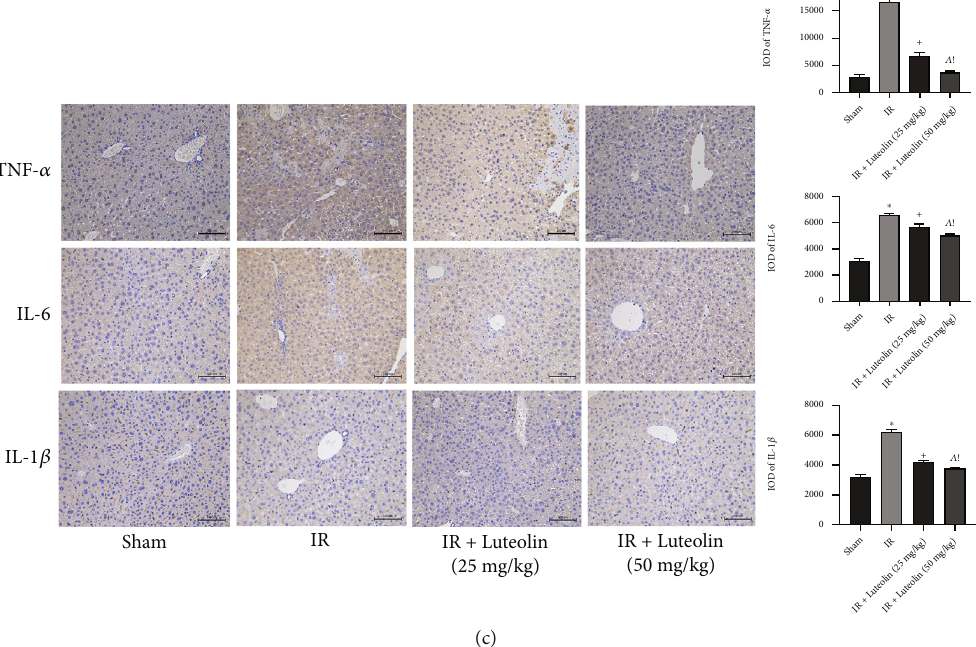
Figure 3: Luteolin reduced the expression of in fl ammatory cytokines. (a) Relative IL-6, IL-1 β , and TNF- α mRNA levels were determined by qRT-PCR. (b) Western blot results of TNF- α , IL-6, and IL-1 β protein levels. (c) Immunohistochemical staining (200x) showed expression of TNF- α , IL-6, and IL-1 β proteins in liver tissues 6 hours after reperfusion. Final evaluations were made by Image-Pro Plus 6.0 software to calculate the IOD of the positive staining area. Data are presented as mean ± SD ( n = 6 ; ∗ p < 0 : 05 for IR vs. sham; + p < 0 : 05 for IR +luteolin (25 mg/kg) vs. IR; ^ p < 0 : 05 for IR+luteolin (50 mg/kg) vs. IR; ! p < 0 : 05 for IR+luteolin (50 mg/kg) vs. IR+luteolin (25